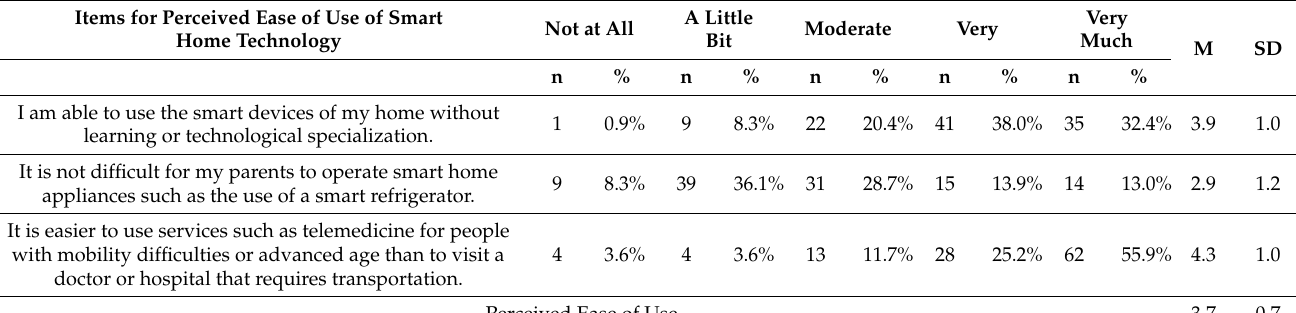
Table A2. Perceived ease of use of smart home